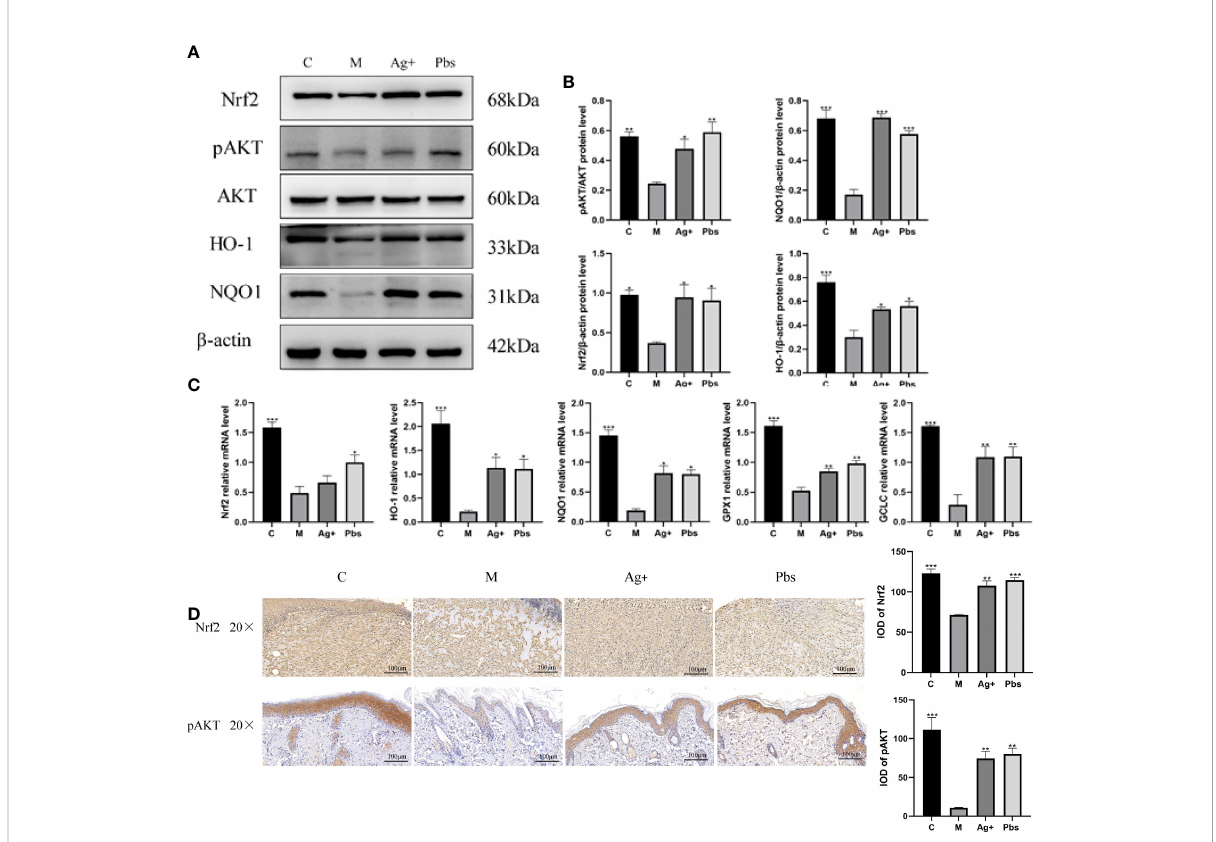
FIGURE 5 Puffball spores activates Akt/Nrf2/HO-1 signal transduction to promote wound healing (A, B) Protein levels of AKT, pAKT, Nrf2, NQO1, and HO-1 protein levels in wound tissue. (C) Nrf2, NQO1, GCLC, GPX1, and HO-1 gene expression in wound tissue. (Means ± SEM, n = 3; *P < 0.05, **P < 0.01, ***P < 0.001 vs. Model group). (D) Nrf2, pAKT expression in wound tissues was detected by immunohistochemistry (scale bar = 100 µm; magni fi cation, 200×; n =